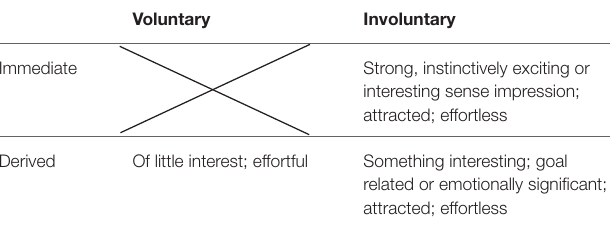
TABLE 1 | Three kinds of attention according to William